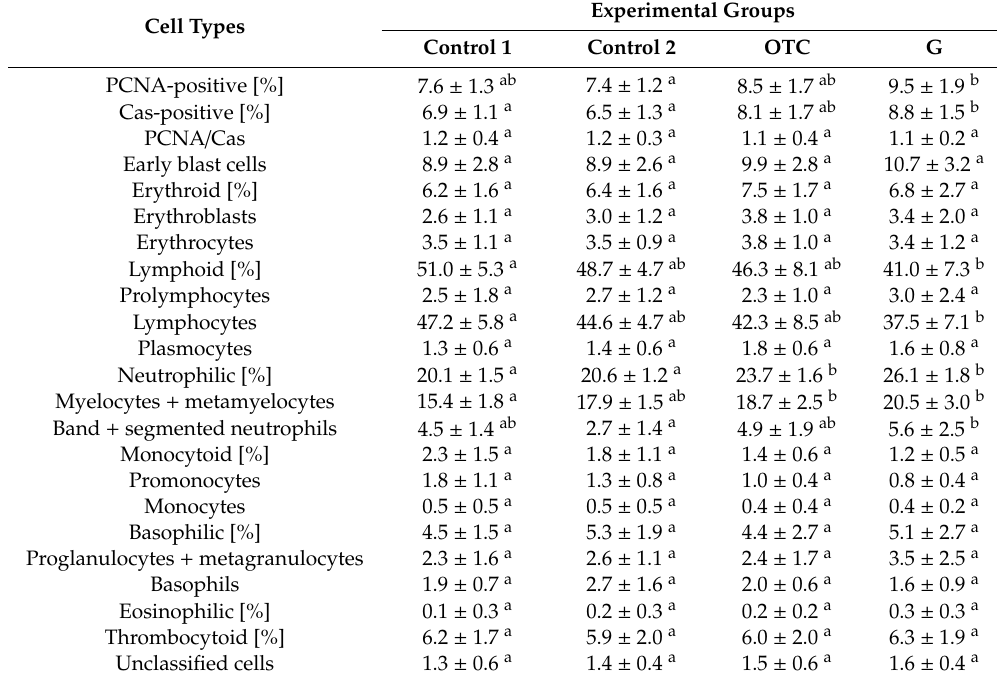
Table 2. The e ff ects of oxytetracycline and gentamicin on the proliferative and apoptotic activity and cellular composition of hematopoietic tissue in common carp (Control